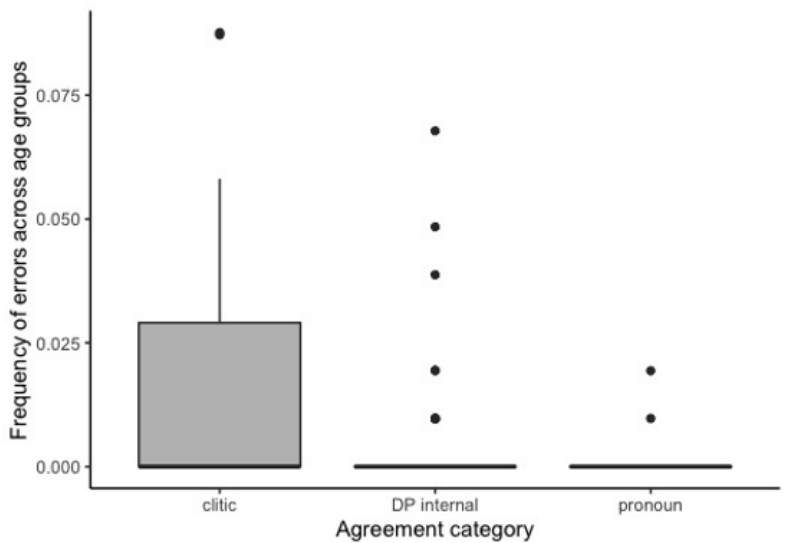
Figure 2. Normalized frequency of errors for each agreement category (clitic, DP internal, pronoun) across age groups (adult, adolescent) within the USA group.